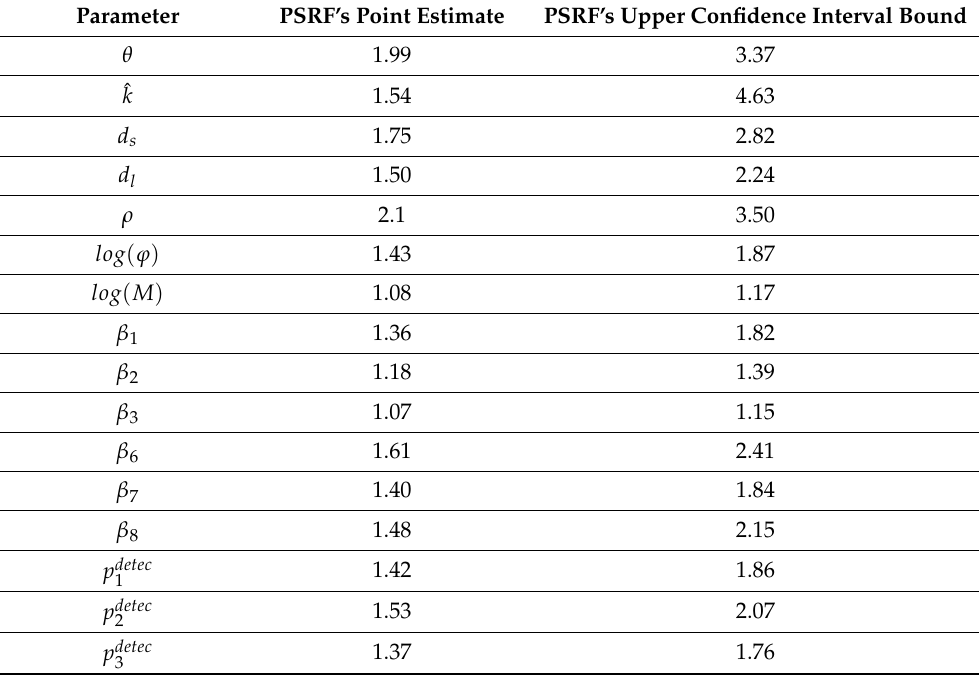
Table A1. Point estimate and upper confidence interval of the univariate Gelman and Rubin conver- gence criteria (PSRFs; Brooks & Gelman, 1998) for each of the main model parameters. These criteria were computed on the 9 chains of the last MCMC session. The multivariate upper bound (MPSRF), accounting jointly for all parameters, was 2.80. Values closer to 1 indicate a better